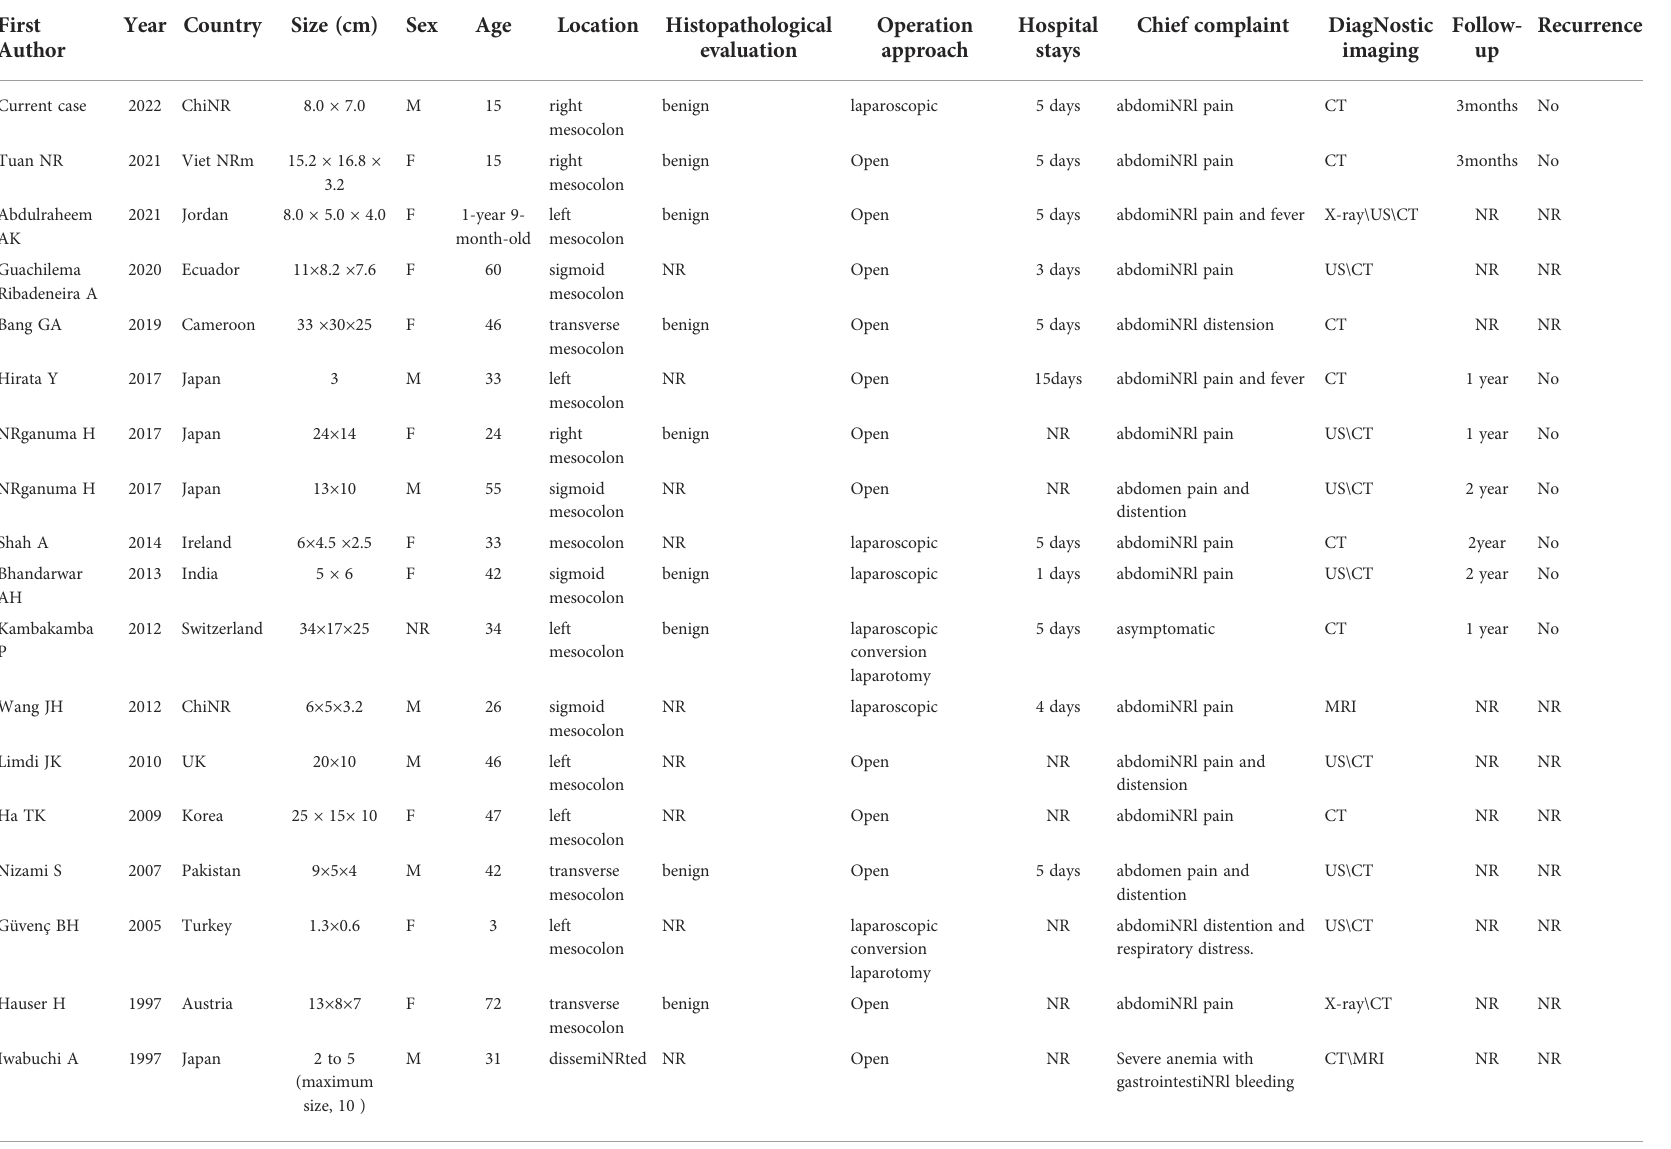
TABLE 2 A summary of reported mesocolic lymphangioma, arranged by